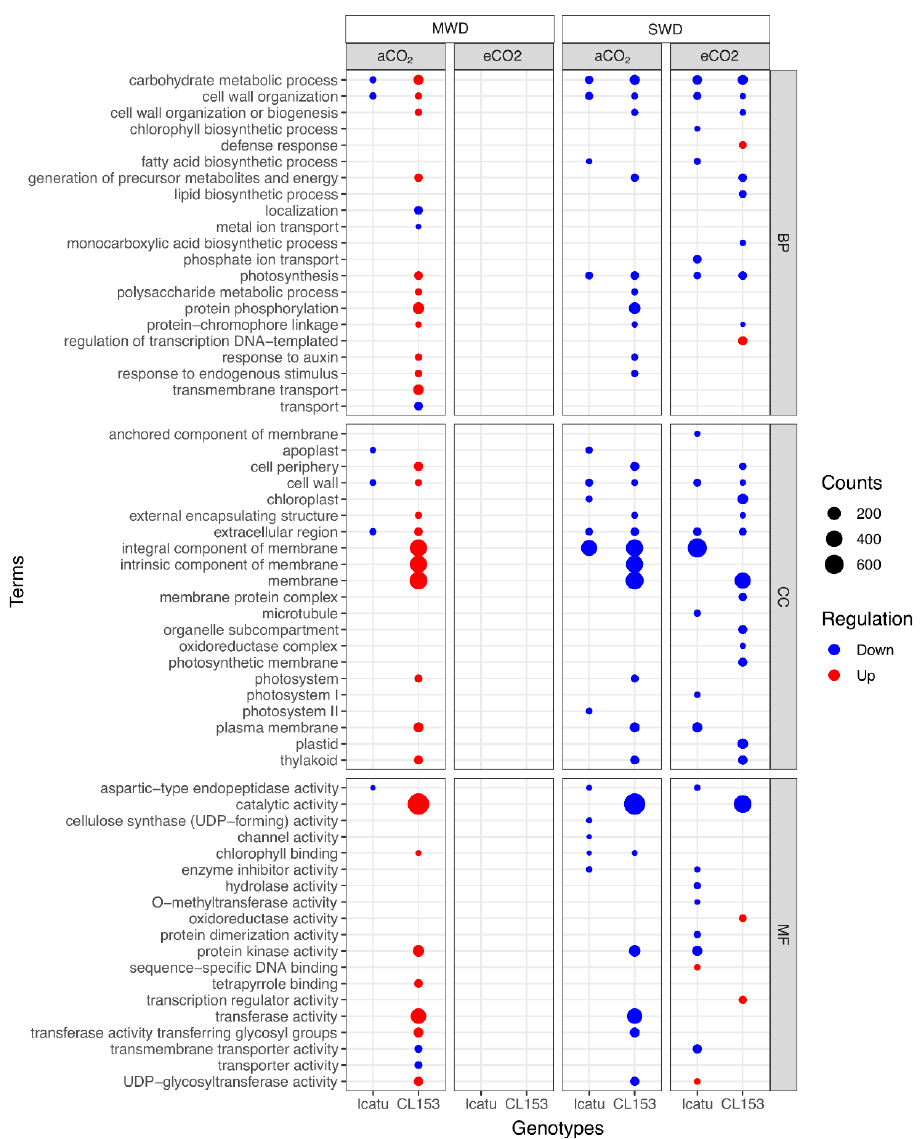
Figure 6. Over-representation analysis of gene ontology (GO) terms found among Icatu and CL153 DEGs performed with gProfiler against the functional annotation of Coffea arabica and Coffea canephora genomes, respectively. Significantly (g:SCS < 0.01) enriched GO was ranked by decreasing log 2 fold-change (FC), considering the effect of MWD or SWD in comparison with WW plants grown under aCO 2 or eCO 2 , at 25/20 °C (day/night). Dot plots with all GO terms were filtered by REVIGO with similarity = 0.5, and a count > 10 cut-offs. Terms are grouped by the main category: Biological Process (BP), Molecular Function (MF), and Cellular Component (CC). Counts (size) indicate the number of DEGs annotated with each GO term and color represents the type of regulation (blue: down-regulated DEGs; red: up-regulated DEGs). An absence of data in eCO 2 under MWD indicates the absence of enriched GO terms.